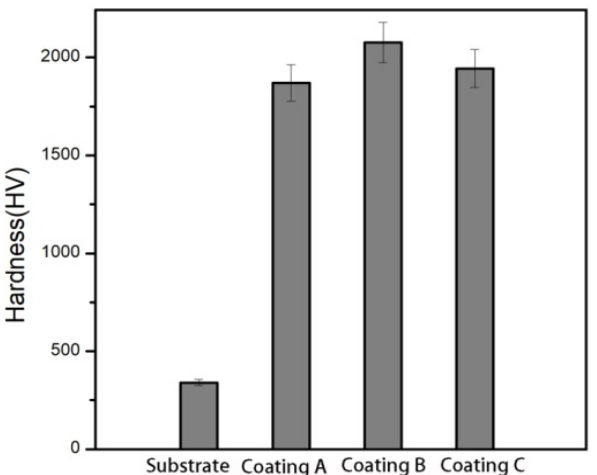
Figure 4. Vickers hardness of different samples.